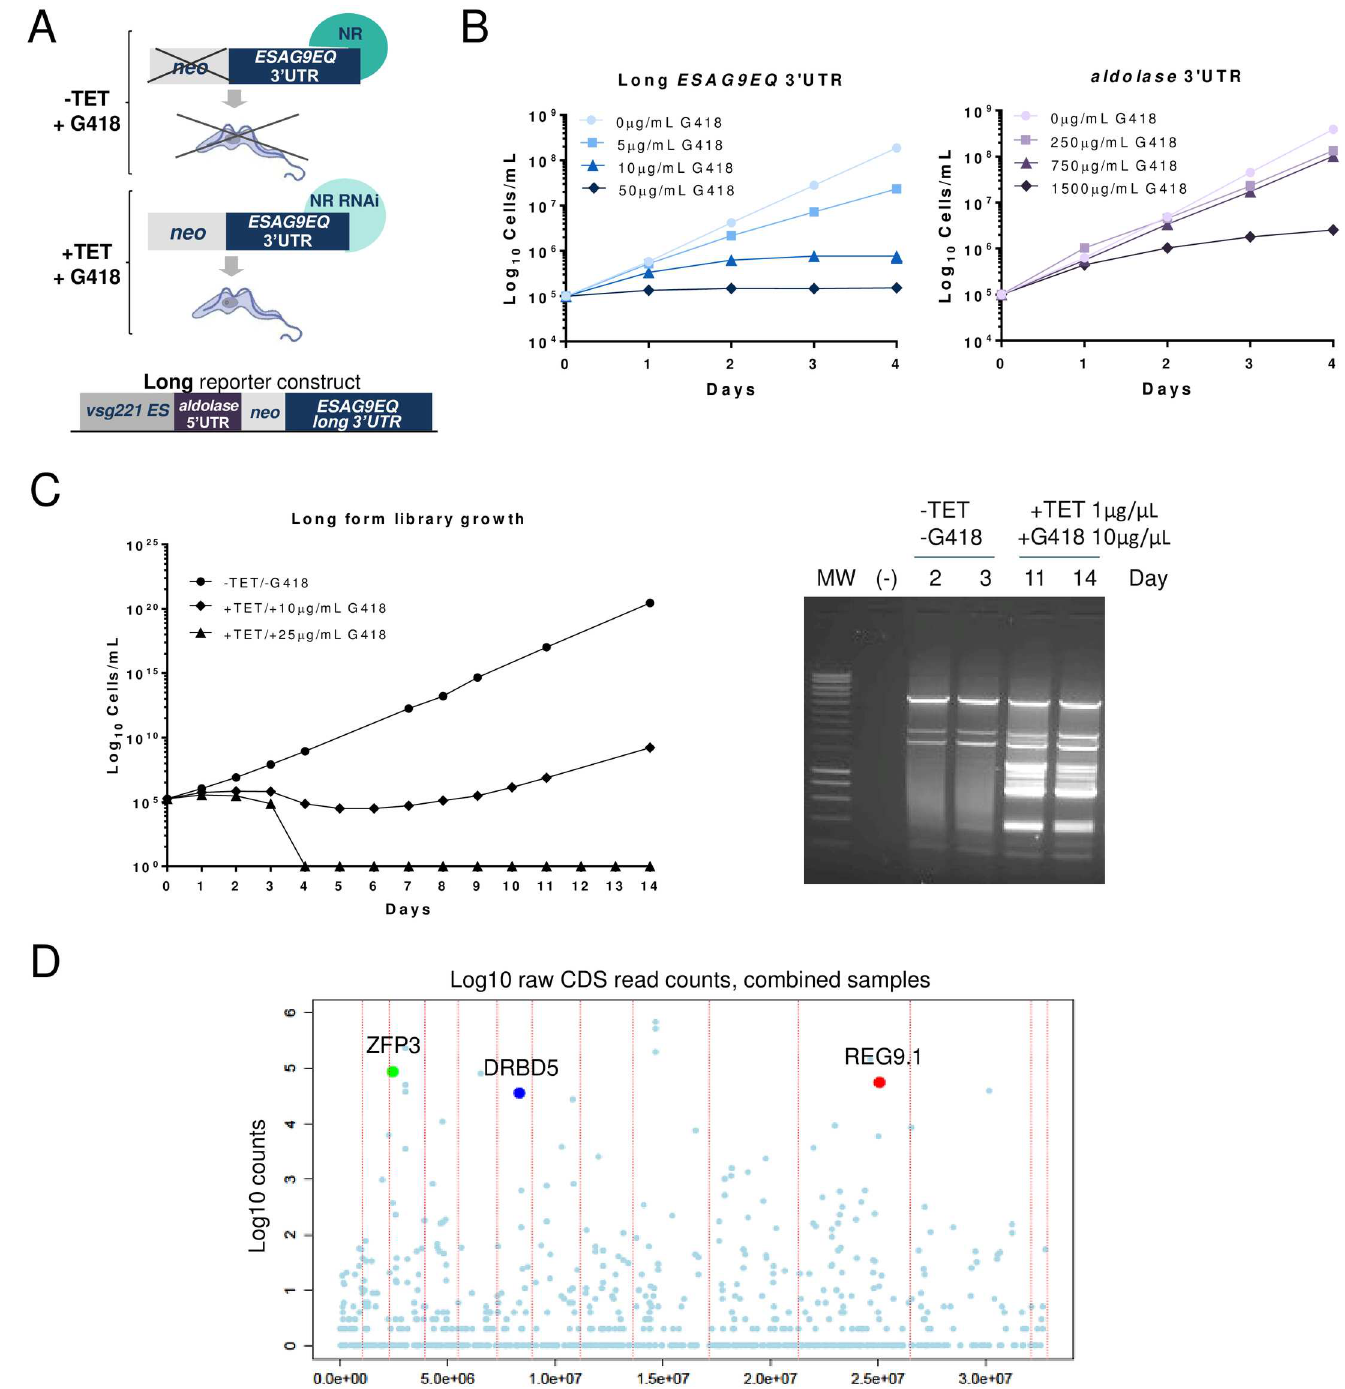
Fig 1. Selection of negative regulators of stumpy enriched transcript expression. A. Schematic representation of the selectionschema to isolate negative regulators of ESAG9 expressionin slender forms; NR denotesa negative regulator.The selection construct used to transfect the RNAi library is shown beneath. The NeoR gene is flankedby the 5’UTR of the trypanosome aldolasegene, whilst the 3’UTR is derivedfrom 1057bpdownstreamof the ESAG9 - EQ stop codon (long form reporter, blue). B. Titration of the sensitivity of trypanosome lines with NeoR flankedby either the ESAG9-EQ 3’UTR or aldolase3’UTR. Error bars symbolize standarddeviationsof biologicaltriplicates. C. RNAi library selectionof parasites containing NeoR flankedby the ESAG9 3’UTR (diamonds). The right hand panel shows the library insert ampliconprofile from cells with NeoR flanked by the ESAG9 3’UTR at different stages of selectionin G418 when RNAi was either induced, or not. The gel shows gDNA isolatedfrom untreated(no tetracycline, no G418) parasites at days 2 and 3 (as a control), and treated parasites at days 11 and 14 after exposure to 1 μ g/ml of tetracycline and 10 μ g/mlG418, when parasites were